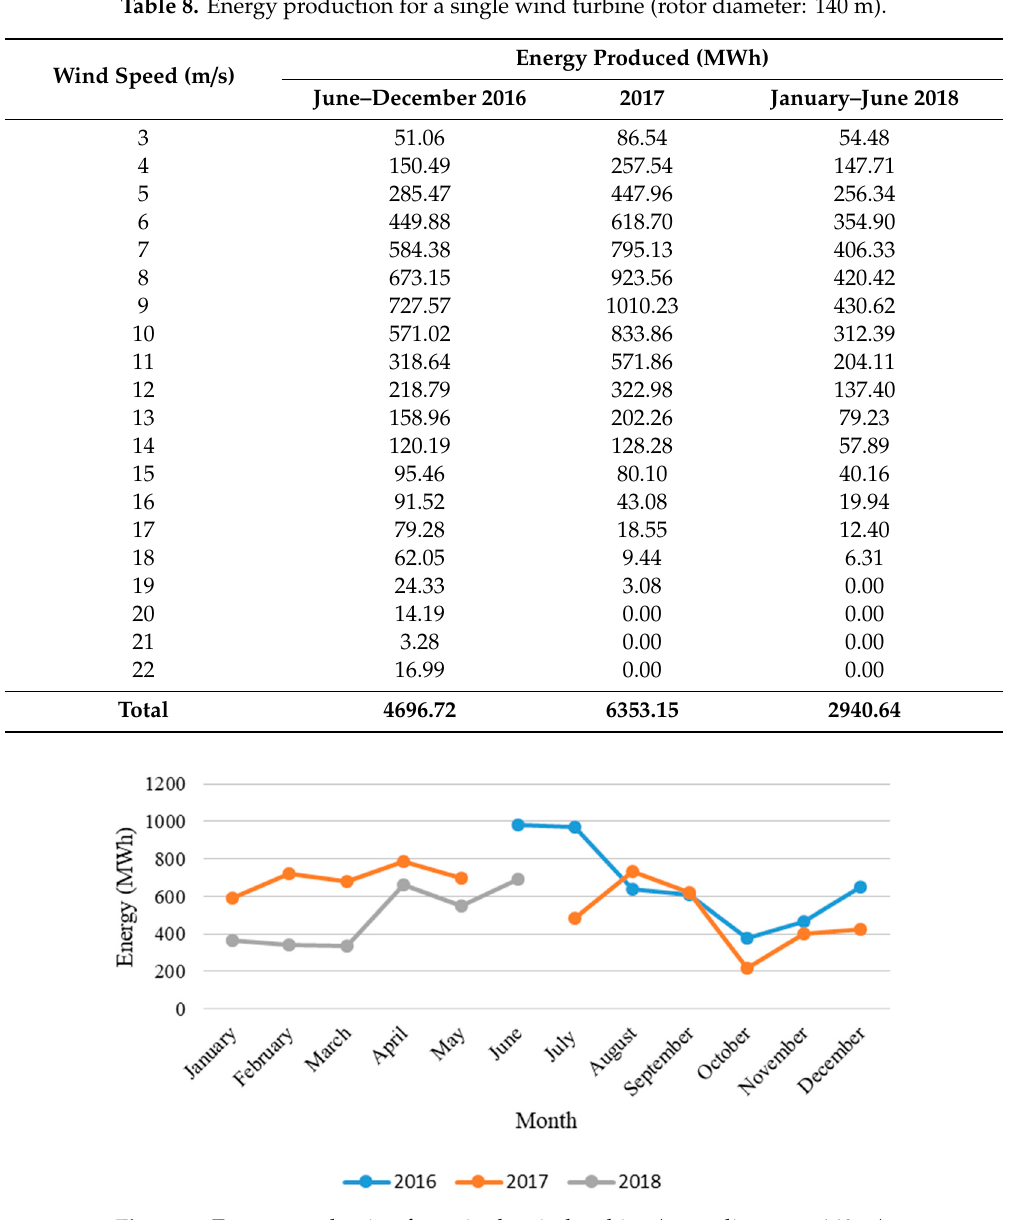
Figure 6. Energy production for a single wind turbine (rotor diameter: 140 m).